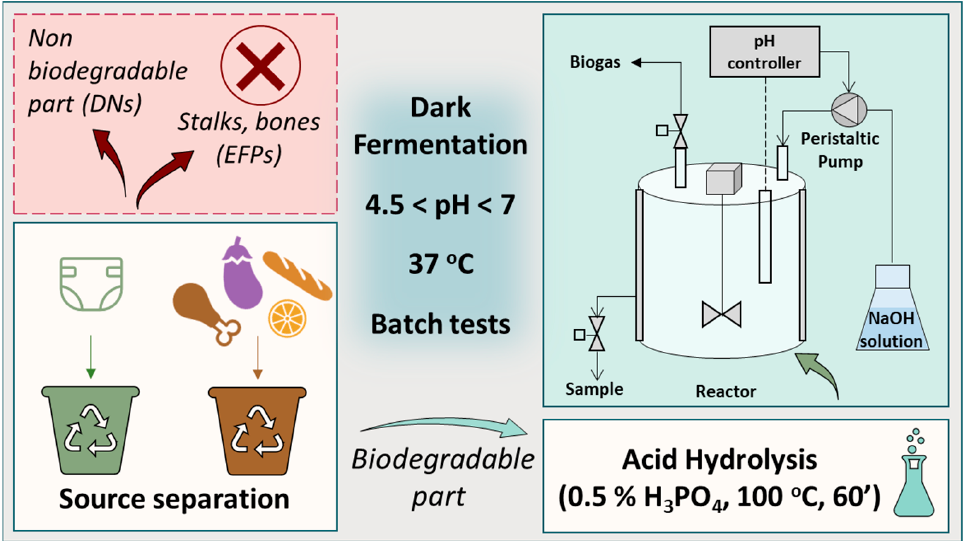
Figure 1. Experimental procedure and set-up of the DNs hydrolysate and EFPs mixture dark fermentation process.